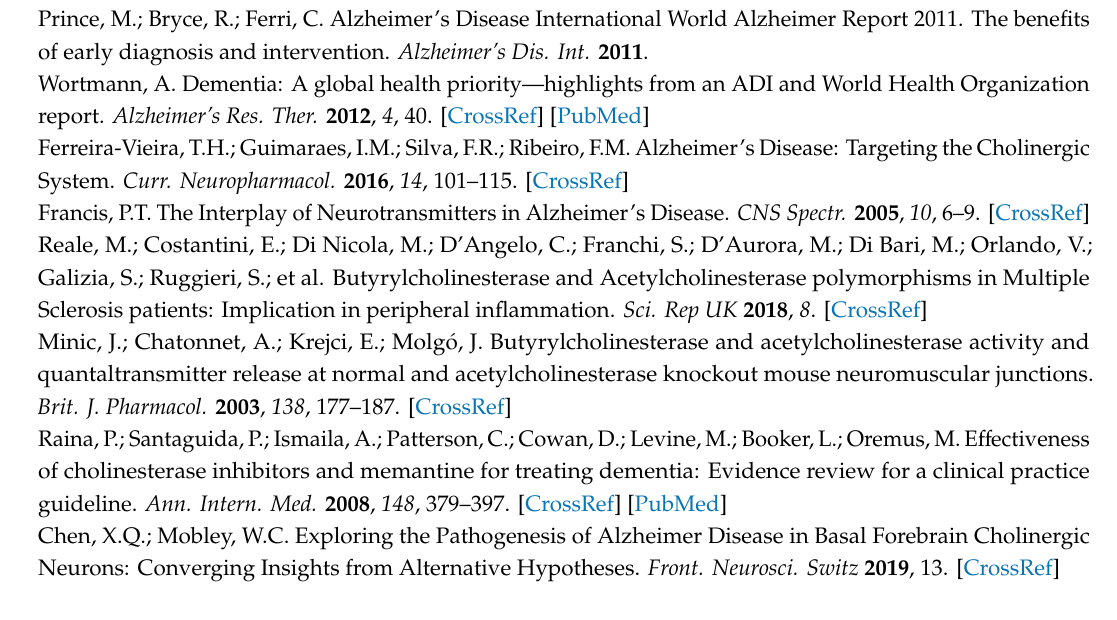
Table S1: Significance of di ff erences in tested teas. AChE inhibition, Table S2: Significance of di ff erences in tested teas. AChE